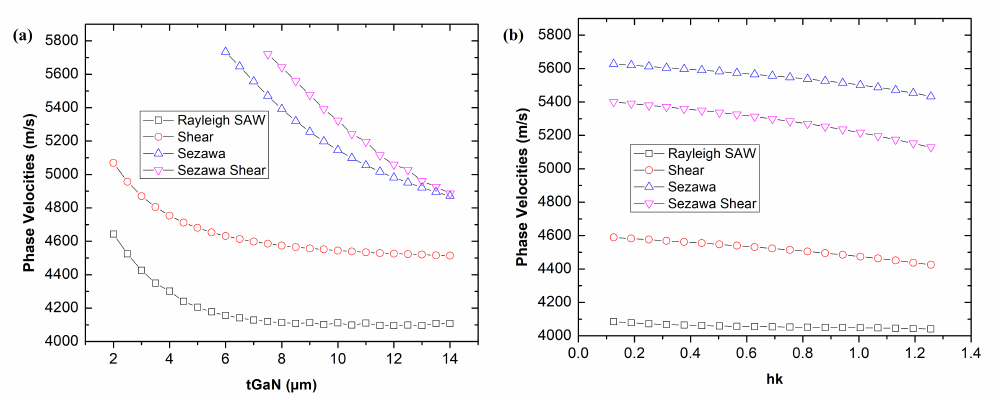
Figure 2. ( a ) Phase velocities as function of the GaN thickness, t GaN without the guiding layer. ( b ) Phase velocities as function of the normalized thickness hk of SiO 2 acting as the guiding